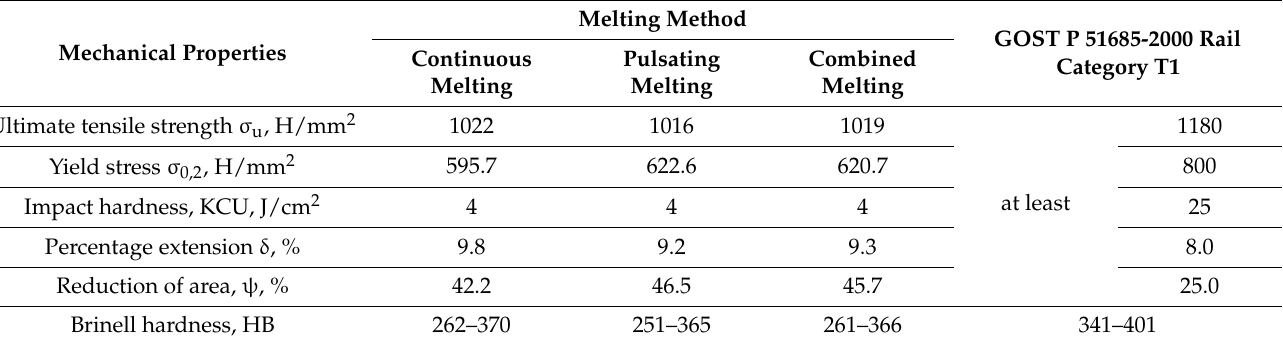
Table 3. Mechanical properties of metal of welded rail head by different methods of electric resis- tance